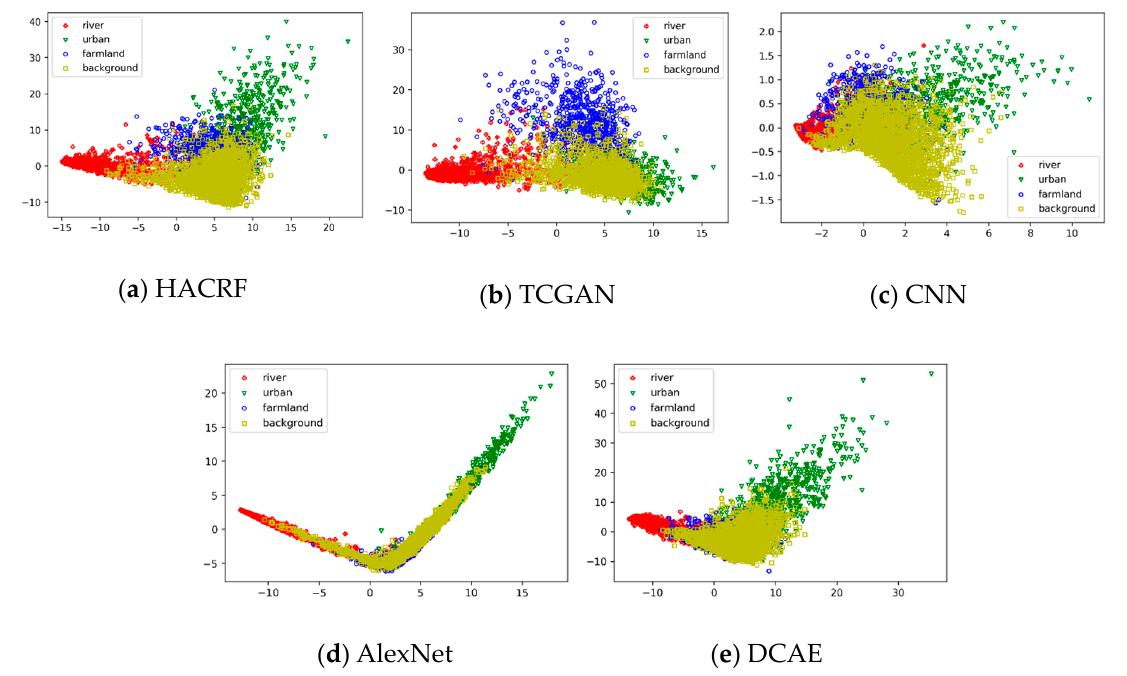
Figure 5. Visualization the features extracted from some testing images using individual methods. ( a ) HACRF; ( b ) CGAN; ( c ) CNN; ( d ) AlexNet; ( e ) DCAE.